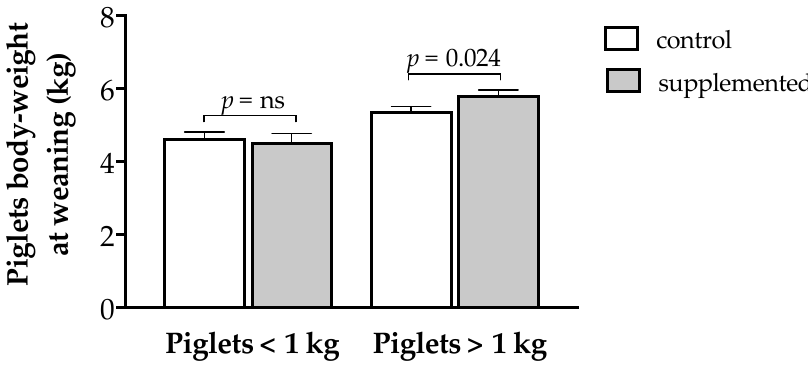
Figure 6. Mean weaning weight ( ± S.E.M.) of piglets with birth weights under and above 1 kg in sows treated or not with herbal antioxidants. ns = not significant.